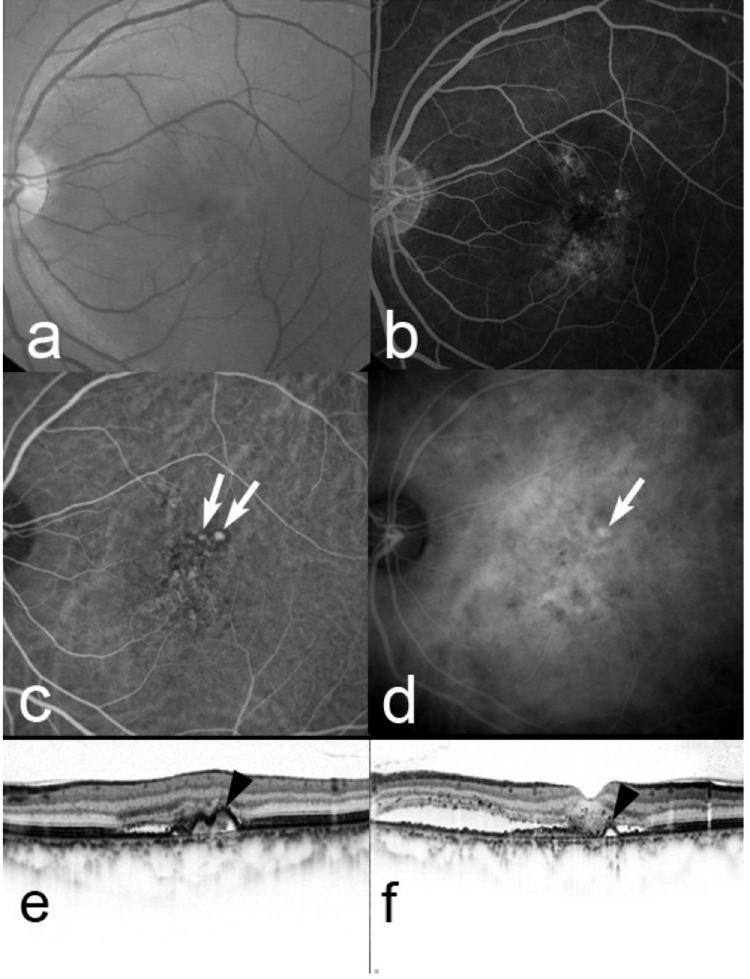
Fig 7. Five months after baseline in the same case as in Fig 6. The decimal visual acuity (VA) remains 0.7. A red-free fundus photograph (a) and fluorescein angiography (b) show a serous retinal detachment (SRD) remaining and occult with no classic choroidal neovascularization. Early-phase (c) and late-phase (d) indocyanine green angiography (ICGA) images clearly show branching choroidal vascular networks and polypoidal lesions (arrows). Horizontal (e) and vertical (f) optical coherence tomography images show a SRD and anterior protrusion of the retinal pigment epithelial line (arrowheads), which corresponds to the polypoidal lesions on ICGA. The diagnosis should be changed to polypoidal choroidal